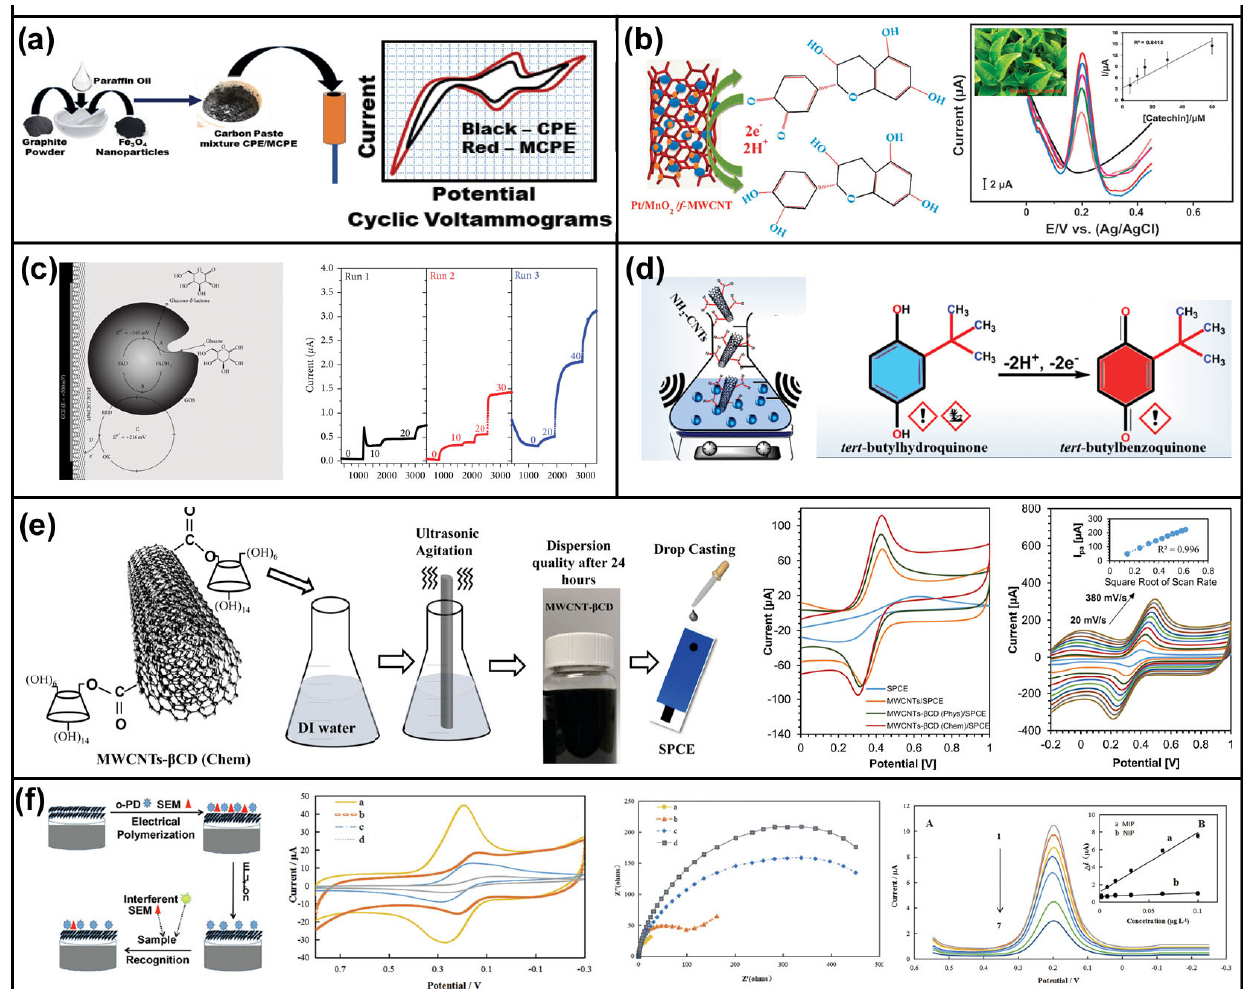
Figure 4. CNT-based electrochemical sensors for food and alcoholic beverage safety. ( a ) Schematic diagram of the phenolic compounds’ electrochemical sensor preparation. Reprinted with permission from [86]. Copyright MDPI, 2021. ( b ) SWV experiments for various concentrations of 0, 5, 10, 15, 30, and 60 mM of green tea leaves extract diluted with catechin concentration. Reprinted with permission from [89]. Copyright The Royal Society of Chemistry, 2015. ( c ) Sensing mechanism. OX and RED are the oxidized and reduced mediator forms, respectively. Reprinted with permission from [90]. Copyright Hindawi, 2016. ( d ) Schematic illustration of TBHQ detection. Reprinted with permission from [91]. Copyright Elsevier, 2021. ( e ) CV curves of different electrodes and different scan rates in an aqueous electrolyte. Reprinted with permission from [92]. Copyright Elsevier, 2020. ( f ) The schematic diagram of the fabrication procedure of the sensor. Reprinted with permission from [94]. Copyright Elsevier, 2020.